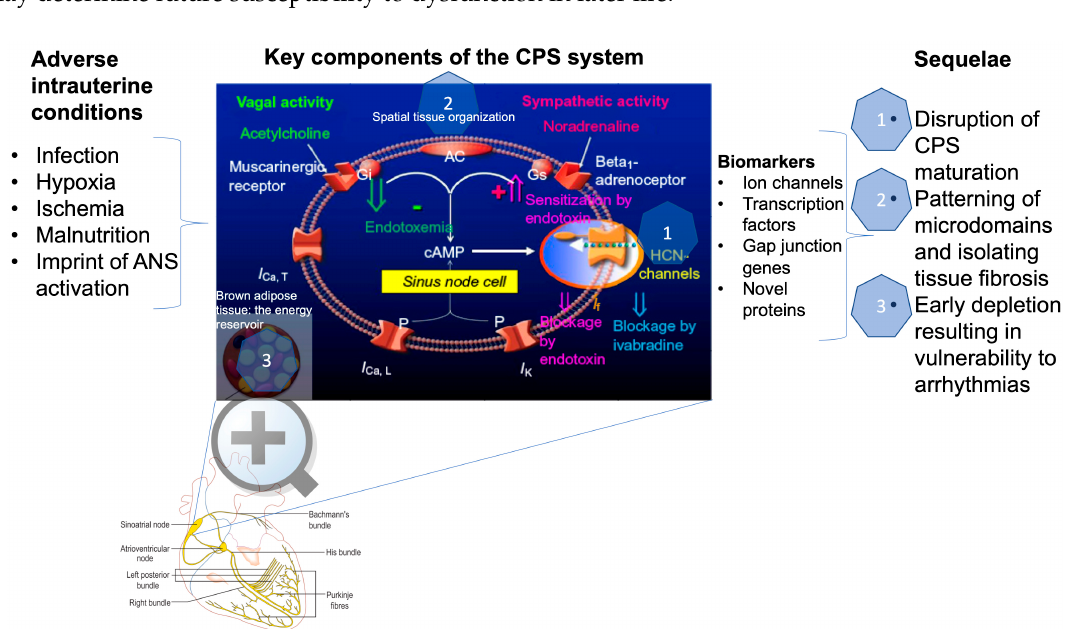
Figure 1. Visual abstract. Adverse intrauterine conditions, such as infection, hypoxia, ischemia, and malnutrition, reprogram the autonomic nervous system (ANS). Together, these adversities impact the three key components of the cardiac pacemaker synchronization (CPS), which are shown in the center blue box (see below for details). The impact is proposed to alter physiology across three conceptual dimensions identified by blue ‐ hued hexagons as follows: (1) direct alteration of the ion channels ʹ function; (2) change in the spatial organization of cardiac pacemaker cells, i.e., their channel microdomains and the isolating tissue; and (3) reduction in the energy availability in brown adipose tissue. In this review, we discuss known biomarkers that represent the ion channel activity, transcription factors, gap junction genes, and novel proteins, whose role is yet to be understood. These biomarkers can be engaged to quantify the compound effect of a greater vulnerability to future insults. This is identified in the left ‐ hand side under sequelae.